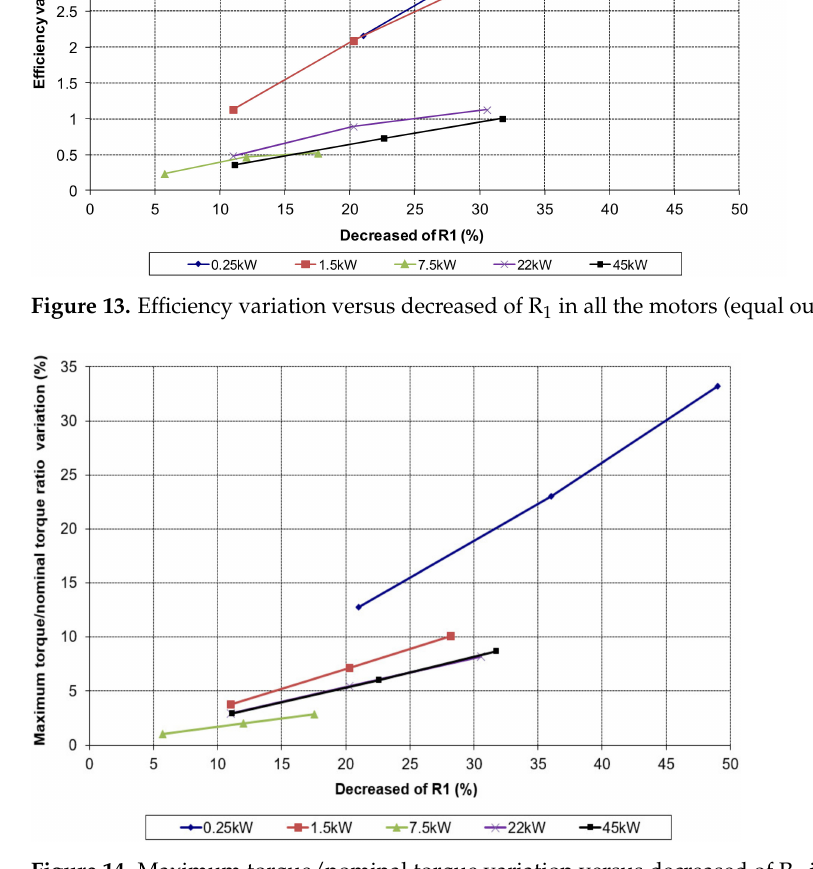
Figure 14. Maximum torque/nominal torque variation versus decreased of R 1 in all the